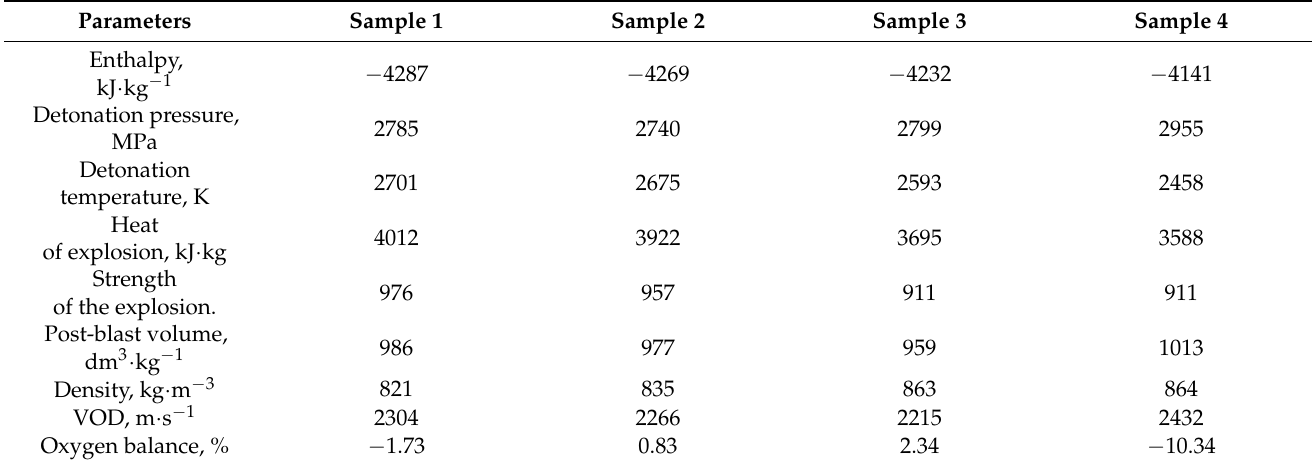
Table 2. Theoretical properties of non-ideal